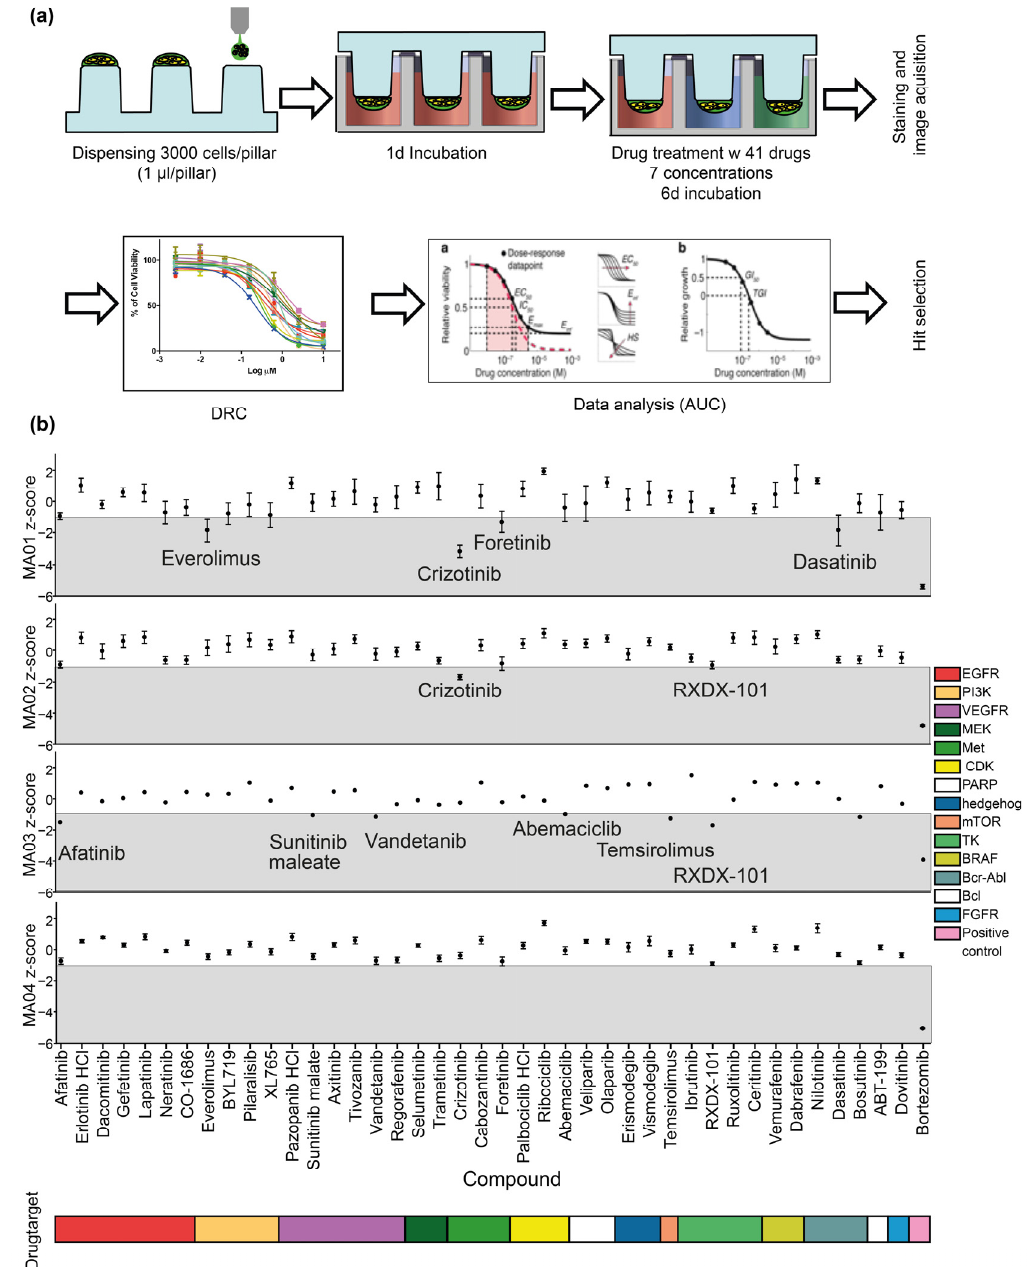
Figure 4. Personalized drug screening. ( a ) Schematic workflow of PD-GBO culture and personalized drug screening. Following a few days of acute spheroid culture, patient-derived tumor cells were printed to form PD-GBOs with alginate as an adhesion matrix on a 384-pillar array using an ASFA spotter. Forty-one FDA-approved drugs were tested in fourfold and seven-point serial dilutions for 6 days. The imaging of calcein-AM-labeled PD-GBOs was semiautomated. We quantified the viable cell population within the PD-GBOs during image analysis, and then used our proprietary software that implements the DRC tool to select candidate drugs (see Supplementary Methods). Thus, about 2 weeks after tumor resection, actionable information was produced for potential clinical application. ( b ) Screening results of PD-GBOs with 41 FDA-approved drugs. Scatter plot of area-under-the-curve ratios by serial diluted (fourfold, seven-point) compound treatments and identification of potential drug candidates in three out of four patients (MA01–MA03) with recurrent